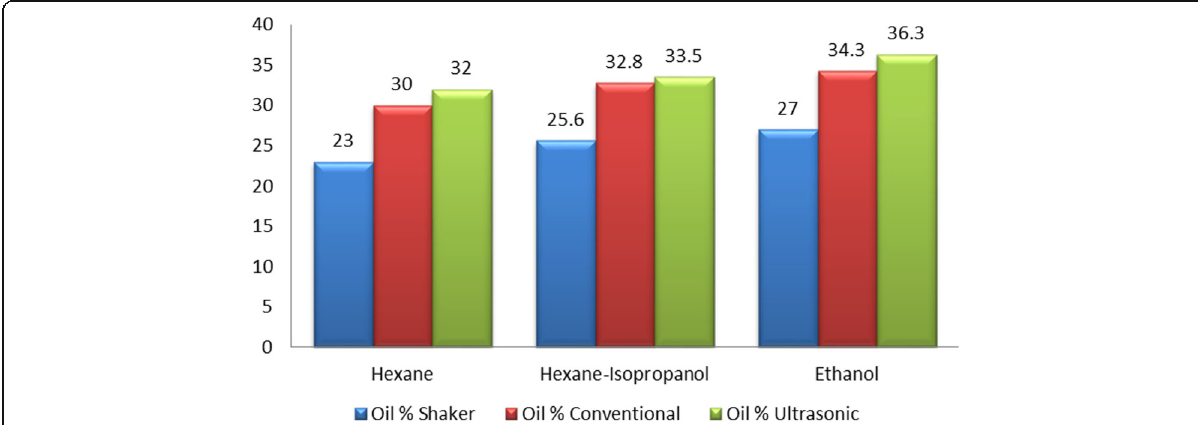
Fig. 1 Effect of different solvent with variant extraction methods on the oil percentage of blank sample